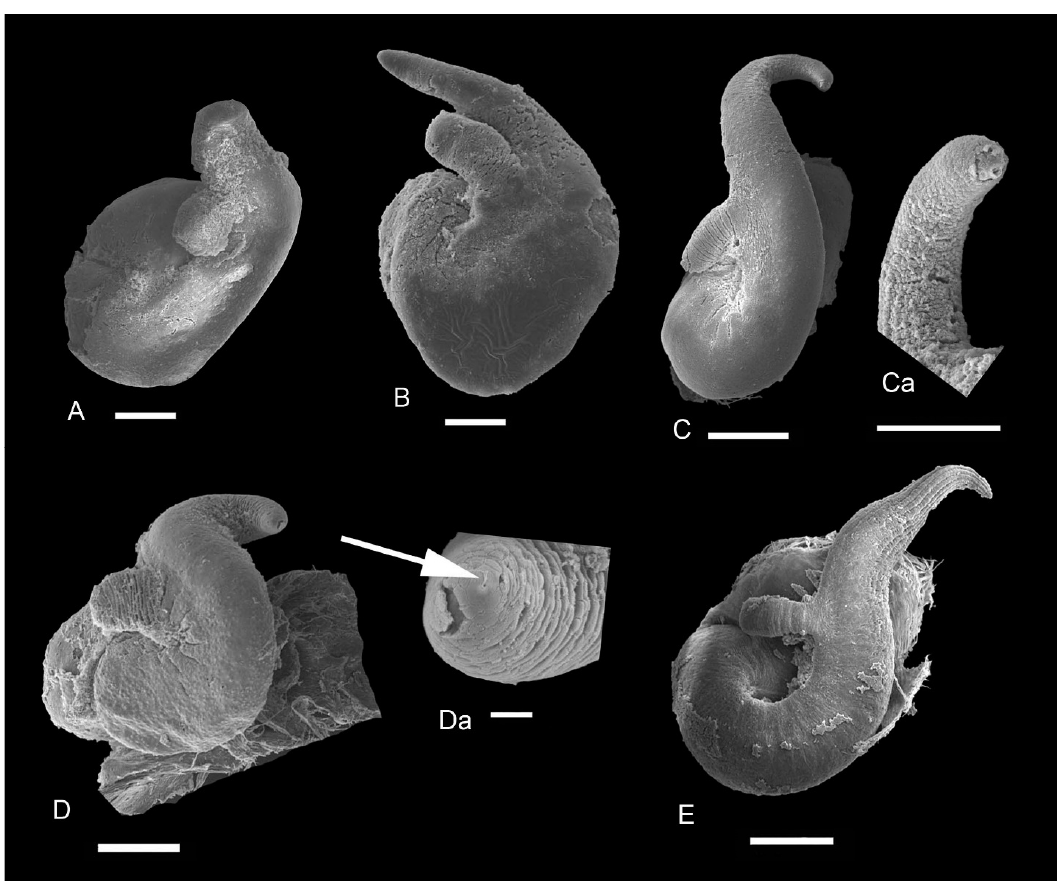
Figure 7. SEM photographs of penises of Kolhymamnicola . ( A ) K. kolhymensis from Perevolochnaya Valley, IBSS, No. 2120b. ( B ) K. ochotica from Kava River basin, IBSS, No. 4325. ( C ) K. wasiliewae from Bol’shoi Bolin River basin, IBSS, leg. L. Prozorova. ( Ca ) increasing tip of the penis; ( D ) K. miyadii from Zelenyi Island, IBSS, No. 518. ( Da ) increasing tip of the penis; ( E ) K. miyadii from Shumshu Island (shell, see Figure 1Gb). Scale bars: ( A , B , D , E ) 100 μ m; ( Ca ) 50 μ m, ( Da ) 10 μ m.